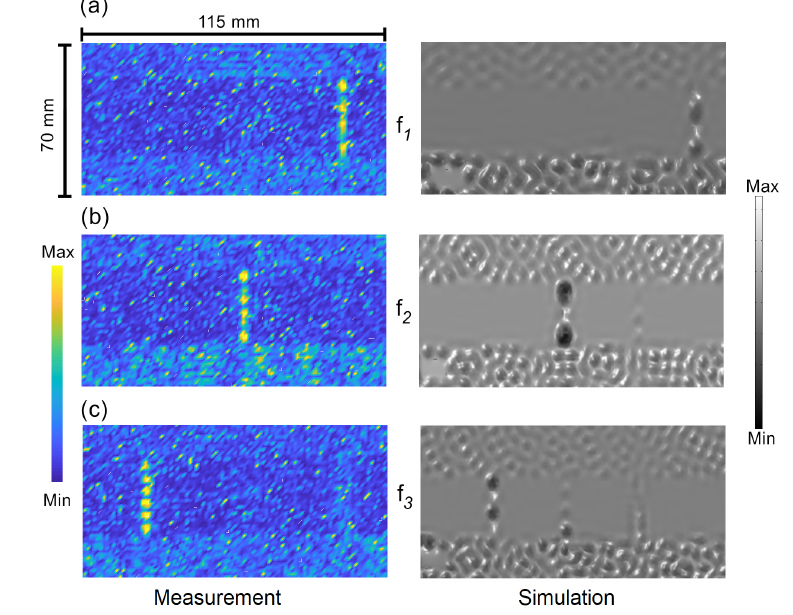
Figure 6. Comparison between simulation and experiment for surface cartography displacement in z-direction for ( a ) W 3 = 0.88 mm at 274 kHz ( b ) W 2 = 1.22 mm at 288.4 kHz (c) W 1 = 1.52 mm at 314